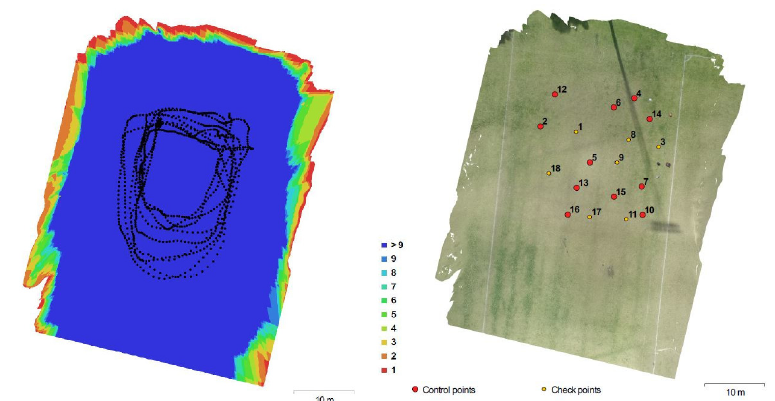
Figure 15. Figure showing the estimated reference trajectory as well as number of overlapping images ( left ) and spatial distribution of control points and check points for one of the iterations ( right)